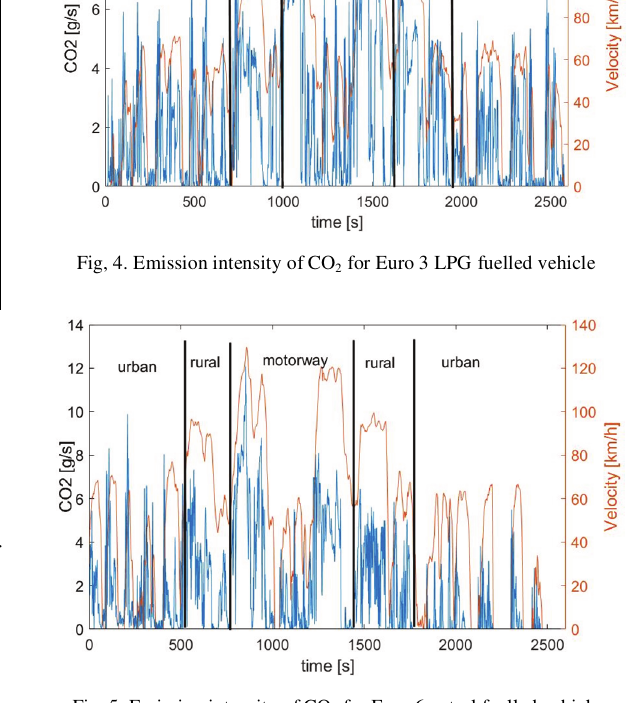
Fig, 5. Emission intensity of CO 2 for Euro 6 petrol fuelled vehicle